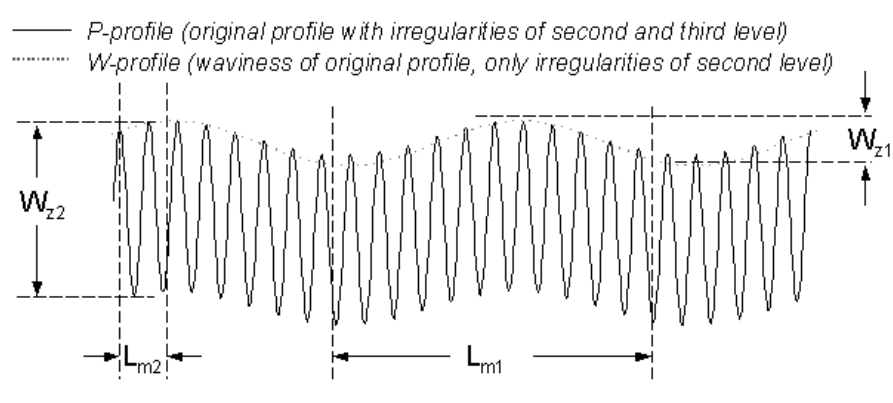
Figure 5. Dependency of wave height on cut-off